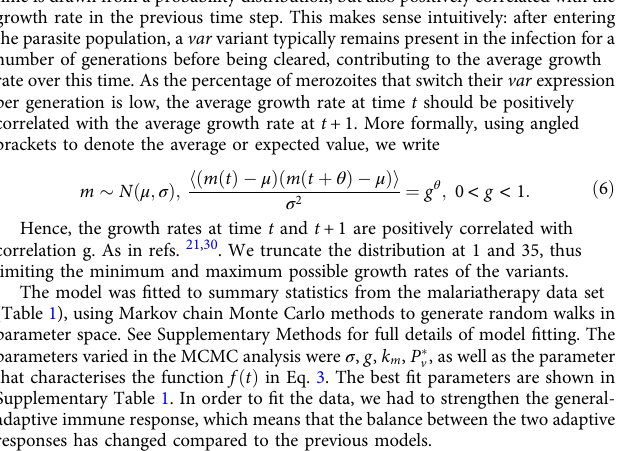
Supplementary Table 1. In order to fi t the data, we had to strengthen the general- adaptive immune response, which means that the balance between the two adaptive responses has changed compared to the previous